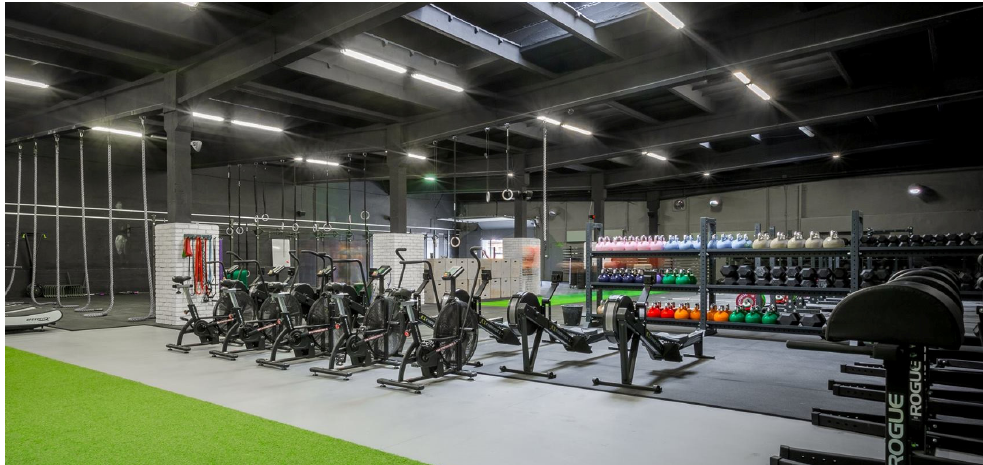
Figure 2. Industrial site adapted to a CrossFit box.